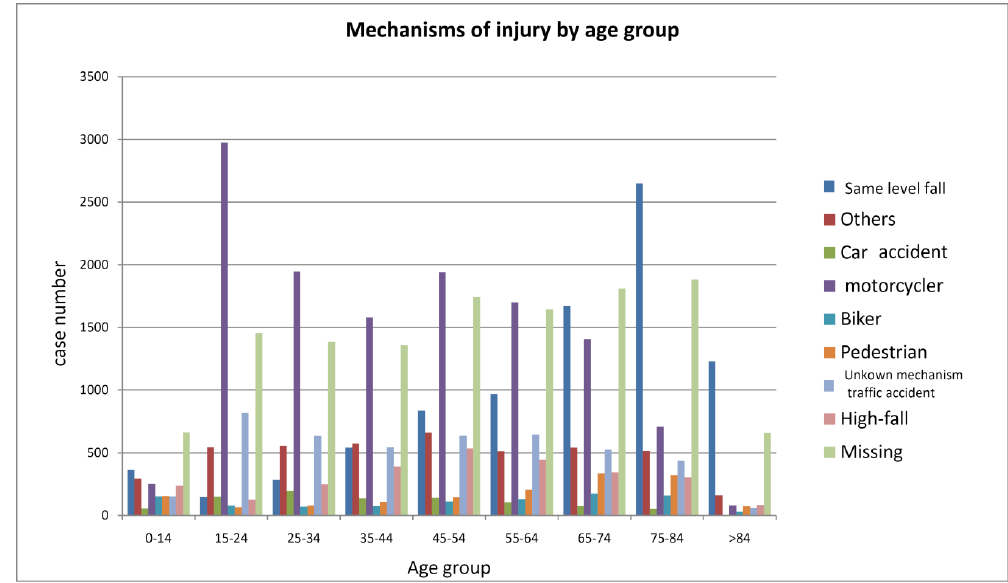
Figure 3. Mechanisms of head injury by age groups.